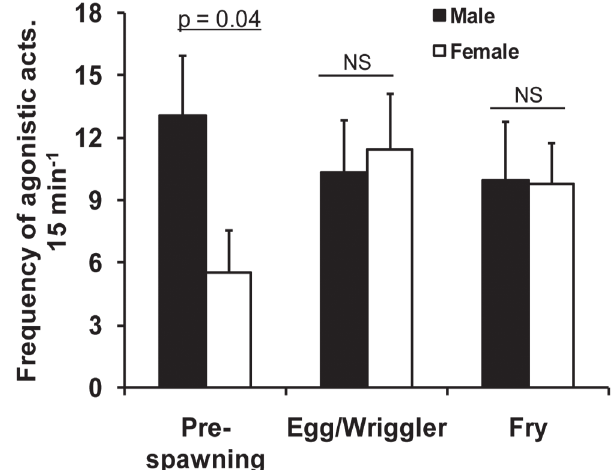
Fig. 3. Mean time (± SE) spent by male and female near the egg/wriggler (n = 11) and free-swimming fry (n = 11). Letters in lower case compare the data between phases; capital letters compare the data between sexes in each phase. Different letters indicate statistical significance (Two-way ANOVA).